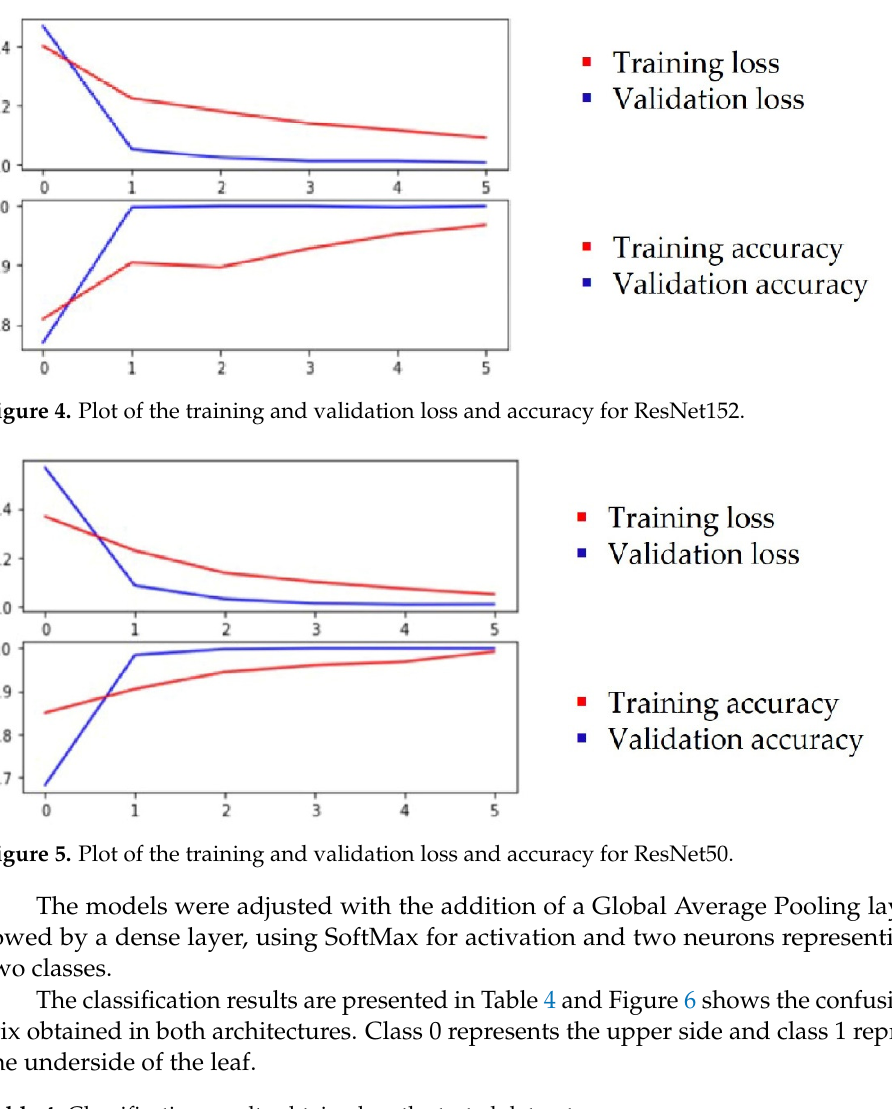
Table 3. Training results.